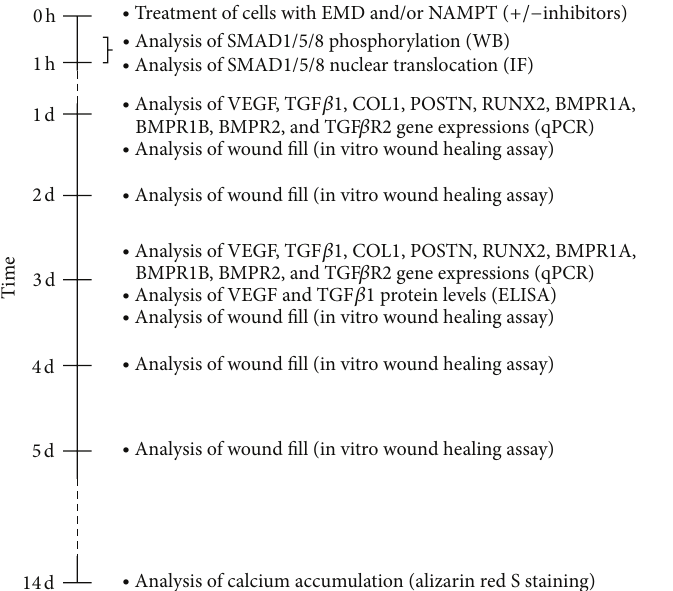
Figure 1: Study design flowchart. EMD: enamel matrix derivative; NAMPT: nicotinamide phosphoribosyltransferase; SMAD: sma- and mad- related protein; WB: western blot; IF: immunofluorescence; VEGF: vascular endothelial growth factor; TGF 𝛽 1: transforming growth factor 𝛽 1; COL1: collagen type I; POSTN: periostin; RUNX2: runt-related transcription factor 2; BMPR1A, 1B, or 2: bone morphogenetic protein receptor 1A, 1B, or 2; TGF 𝛽 R2: TGF 𝛽 receptor 2; qPCR: quantitative polymerase chain reaction; ELISA: enzyme-linked immunosorbent assay.